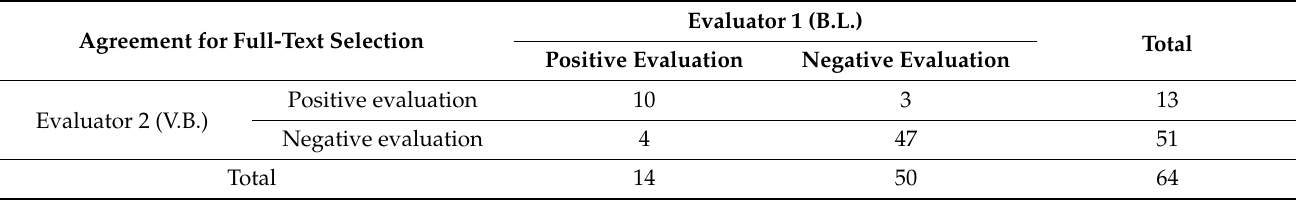
Table 5. Agreement for full-text